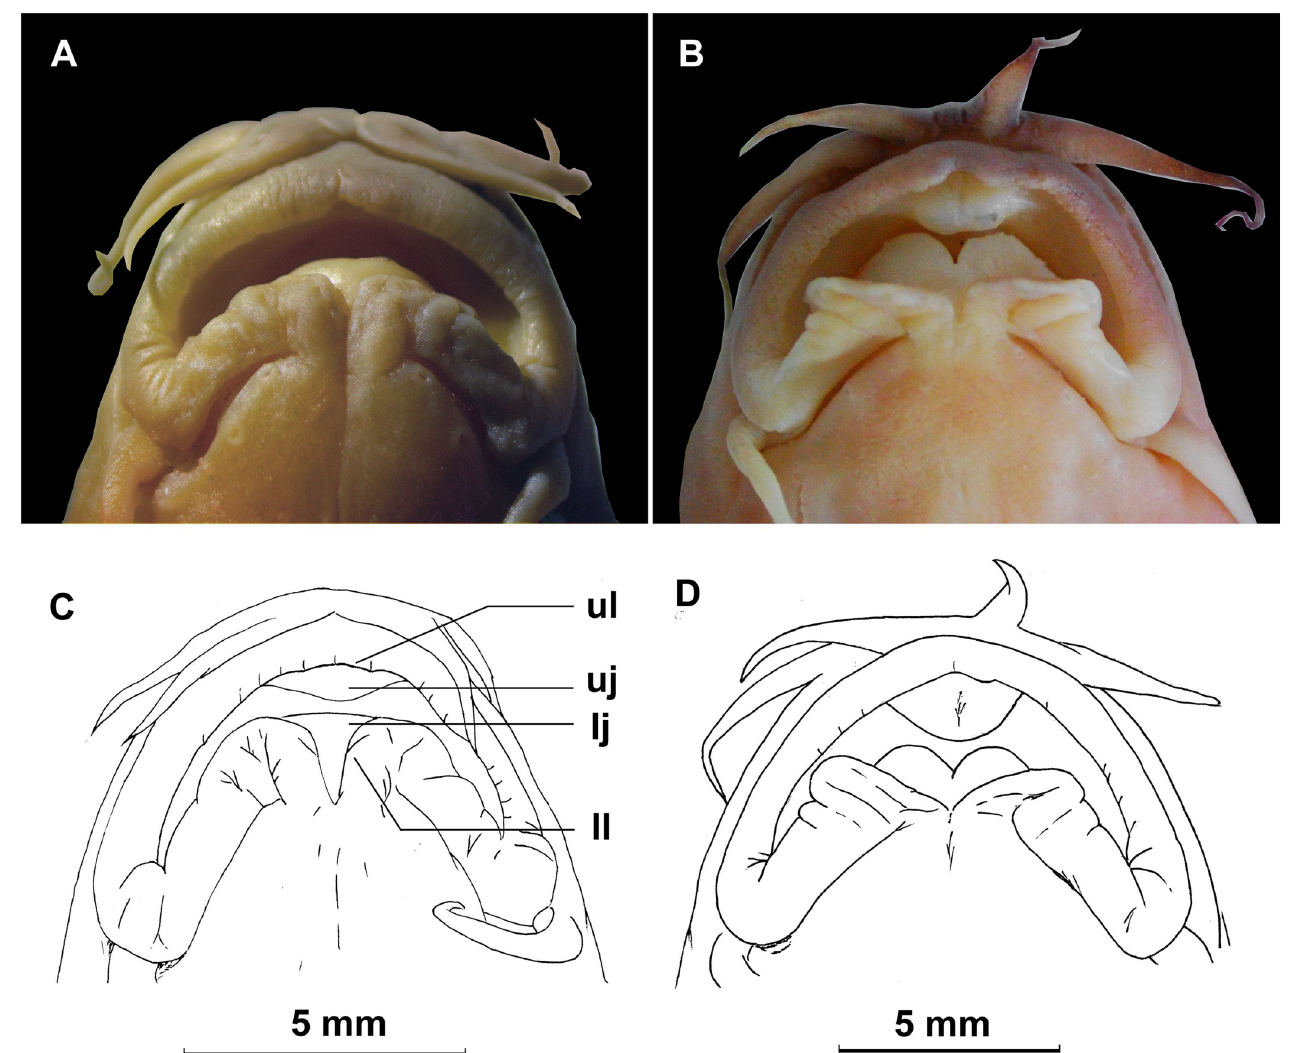
Fig 2. Ventral view of the mouth and shape of the lower jaw. (A, C) Spoon shaped and lacking a median notch, H . geminuclathratus , Paratype SWFU 0309054, 113.4 mm SL; China: Yunnan Prov.: Pu’er City: Jingdong Co.: Wenjing Town. (B, D) Shallow V-shaped median notch on lower jaw, H . change . SWFU 0412001, 115.3 mm SL; China: Yunnan Prov.: Pu’er City: Jiangcheng Co.: Jima-he. (ul: upper lip; ll: lower lip; uj: upper jaw; lj: lower